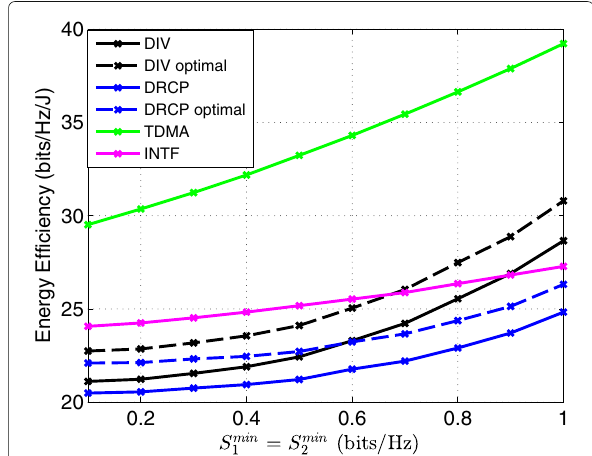
Fig. 9 Energy efficiency of the studied approaches in the transmit power-dominated regime with equal average links